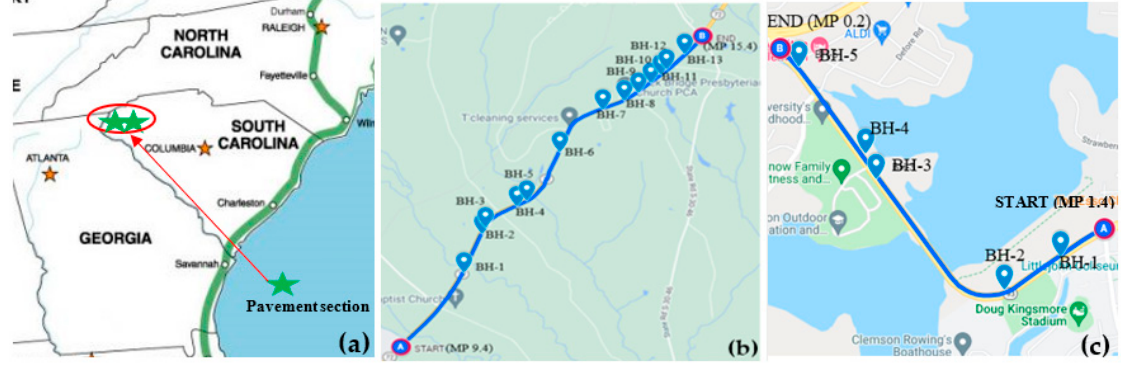
Figure 1. ( a ) Pavement location map and coring Location map for ( b ) Laurens/SC-72